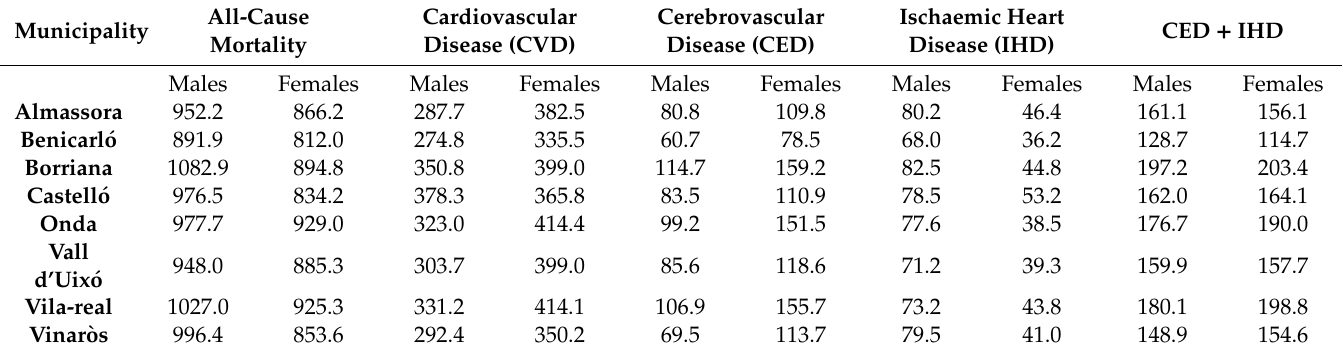
Table 4. Age-adjusted mortality rates per 100,000 inhabitants: males and females (Castell ó n, 1991–2011 period). All-Cause Cardiovascular Cerebrovascular Ischaemic Heart Municipality CED + IHD Mortality Disease (CVD) Disease (CED) Disease (IHD) Males Females Males Females Males Females Males Females Males Females Almassora 952.2 866.2